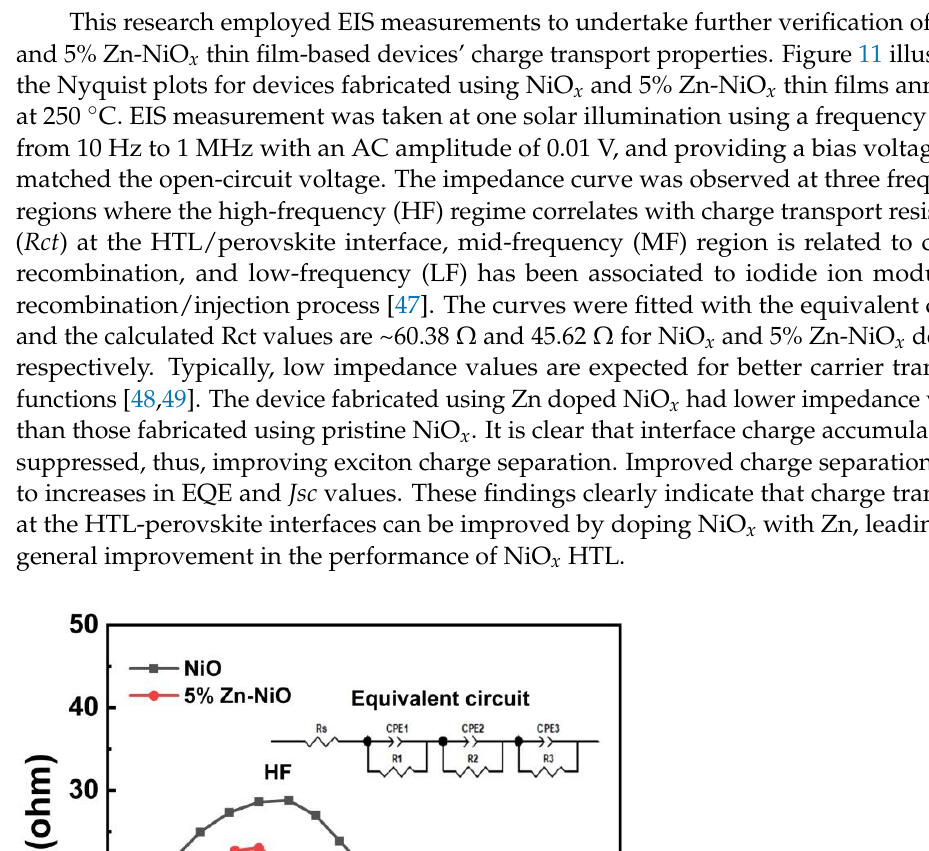
Figure 10. ( a ) PL spectra and ( b ) PL lifetime decay of NiO x and 5% Zn-NiO x thin films.